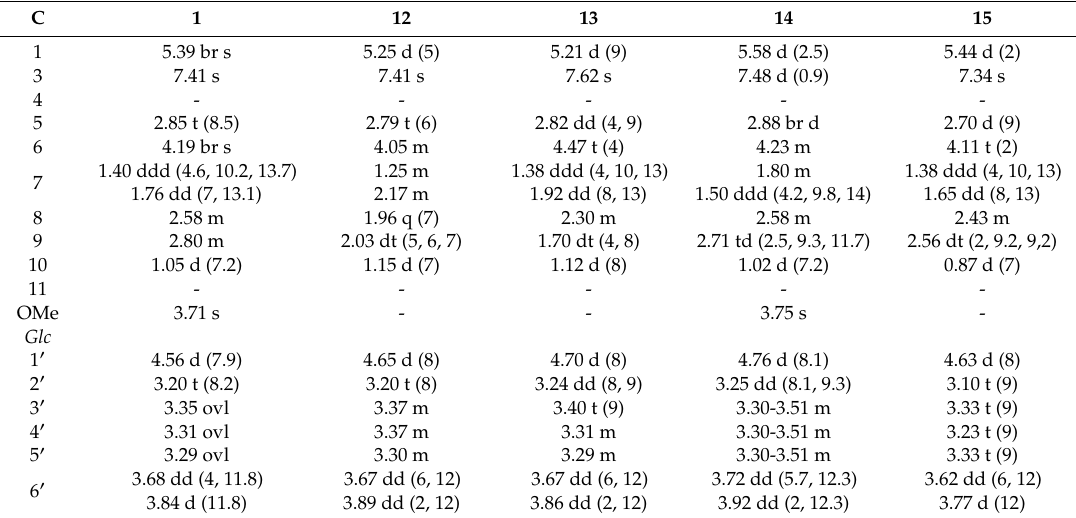
Table 1. 1 H-NMR data of Nepetamoside a ( 1 ), 6 β -dihydrocornic acid ( 12 ) b , 6 α -dihydrocornic acid ( 13 ) b , penstemonoside ( 14 ) c and 8-deoxyshanzhiside ( 15 ) c .